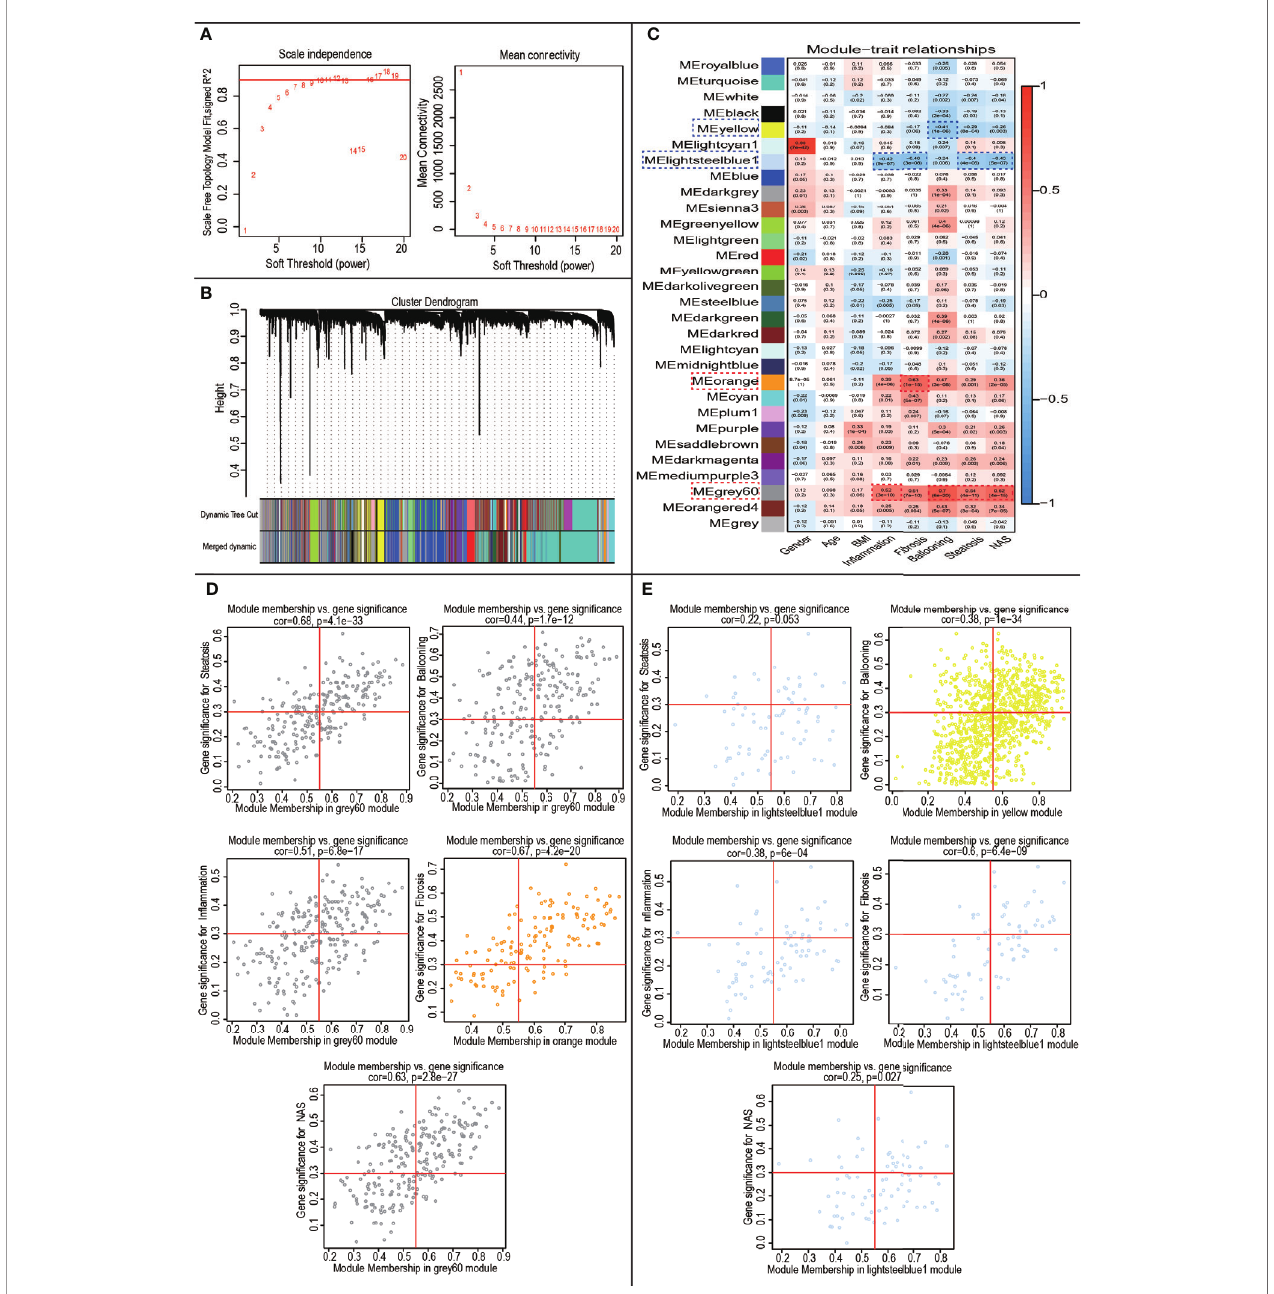
FIGURE 4 | WGCNA to Identify trait-related modules and genes. (A) Calculating soft-thresholding power. Left: scale-free fi t indices using different soft-thresholding powers ( b ). Right: mean connectivity using different soft-thresholding powers; (B) The dendrogram clustered by Dynamic Tree Cut algorithm; (C) The heatmap pro fi ling the correlations between module eigengenes and the clinical characteristics; (D) Scatter plot of trait-related modules (Up-regulated); (E) Scatter plot of trait- related modules